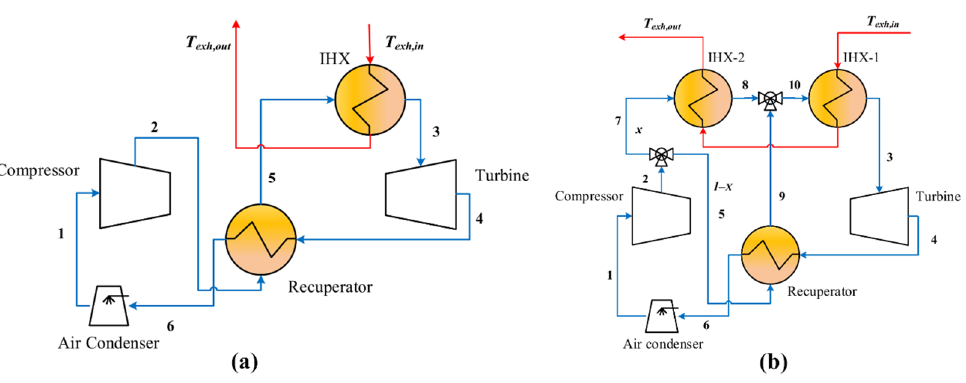
Figure 2. Bottoming cycle configurations: ( a ) Simple regenerative cycle (SRC); ( b ) Partial heating cycle (PHC) . Adapted from [26].